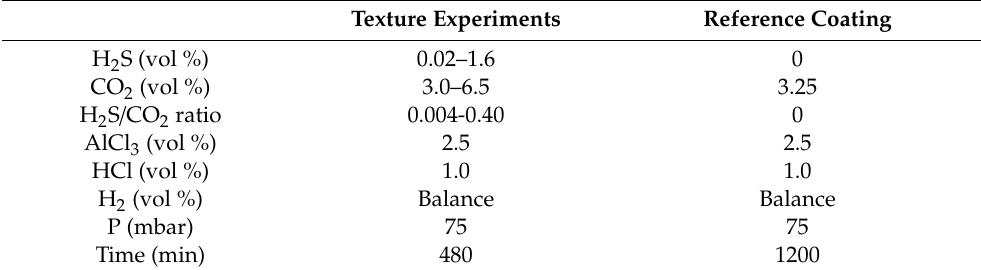
Table 2. Deposition parameters for texture